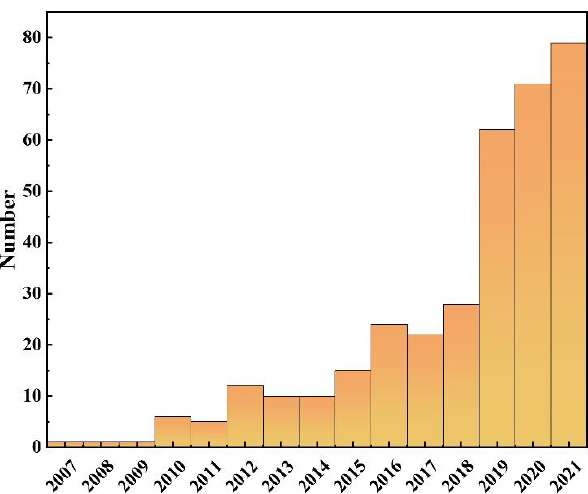
Figure 1. PRISMA flow diagram.